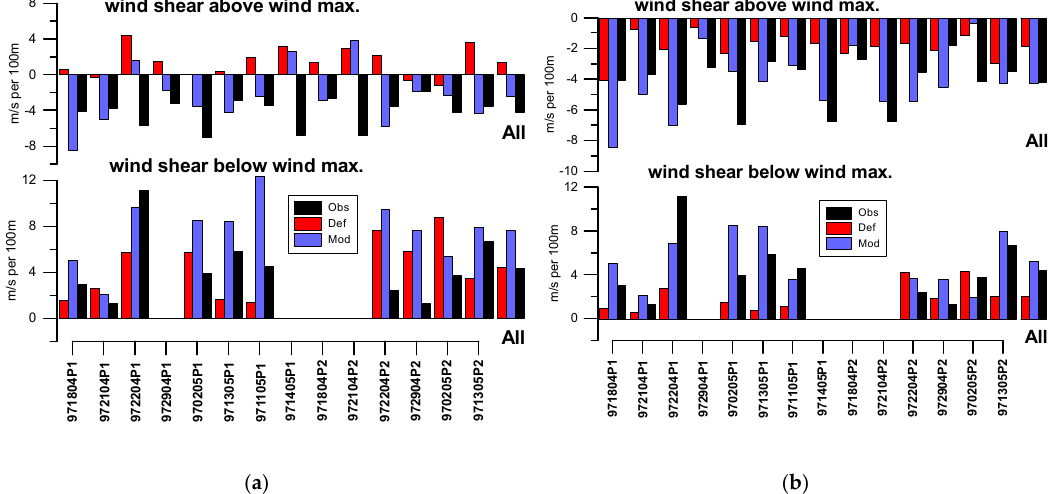
Figure 13. ( a ) Wind speed gradients (all values per 100 m) from aircraft profiles (black) and simulations (def: red, mod: blue) for all KABEG flights (see Table 1) and as an average for all profiles (All). Upper panel : Gradients within 100 m above the observed low-level jet (LLJ), Lower panel : Gradients below the LLJ. ( b ) As Figure 13a, but for wind speed gradients taking LLJ heights individually from observations and from each simulation (see Figure 14 for LLJ heights).